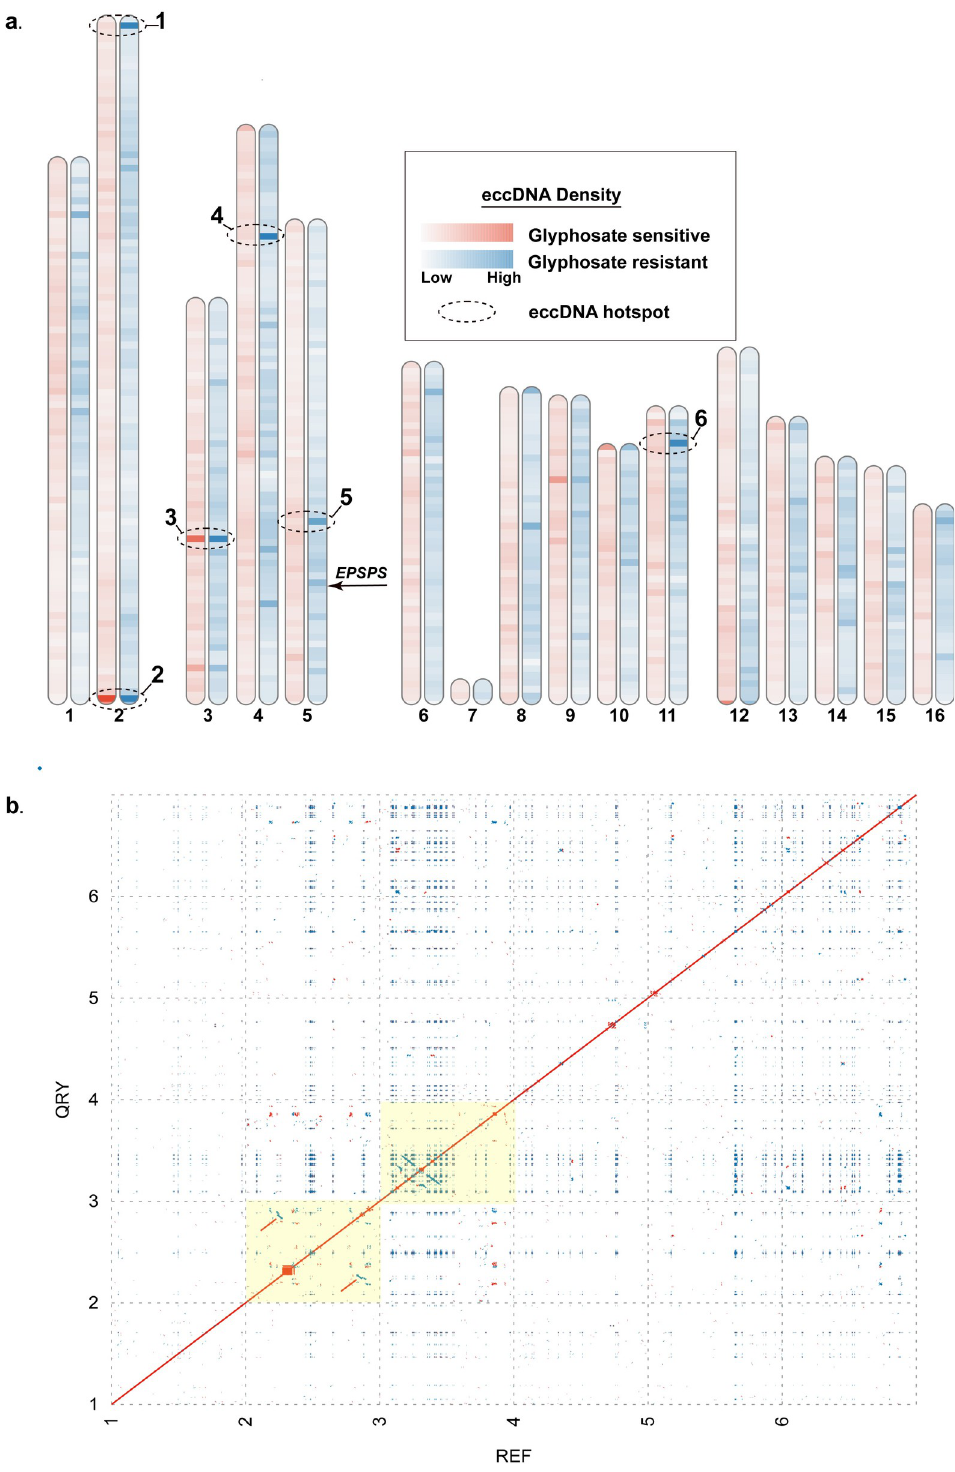
Fig 8. A. Alignment and quantification of unique eccDNA of GS (red) and GR (blue) to the chromosome-scale Palmer amaranthus reference assembly in 500kb non-overlapping windows. Darker colors represent a larger abundance of mapped eccDNA. Regions with the dotted ellipses indicate a high abundance of mapped eccDNA. B. Self-alignment of the 6 highlighted regions from A. Red dots indicated direct repeats, while blue are indirect. Regions highlighted in yellow are derived from the 2 genomic regions (2 & 3 - 500kb each) with the highest abundance of mapped eccDNA.